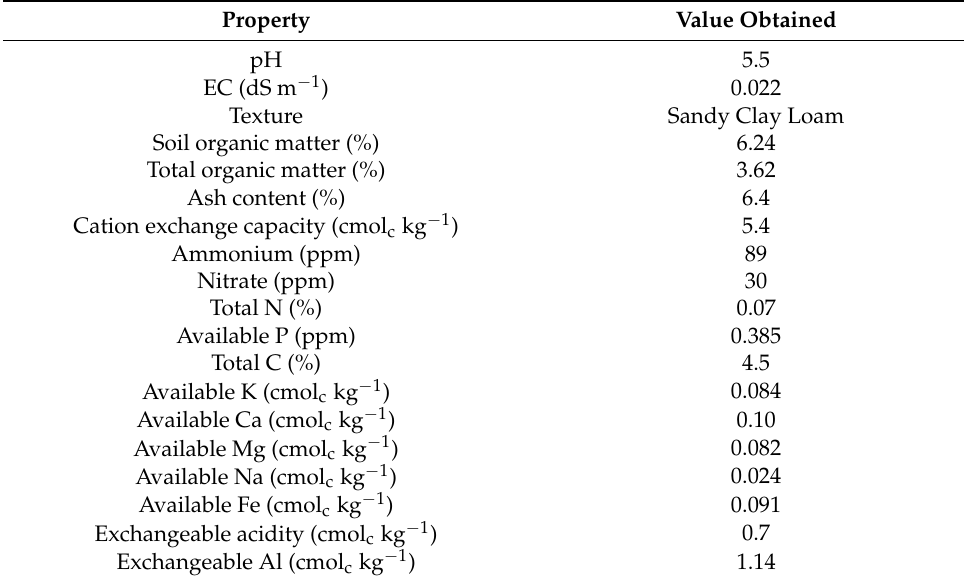
Table 3. Selected soil physico-chemical properties.